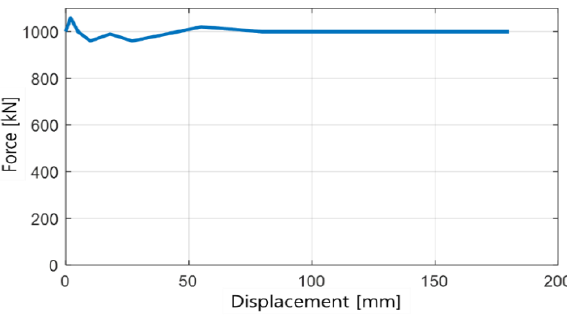
Figure 19. Deformation tube model.